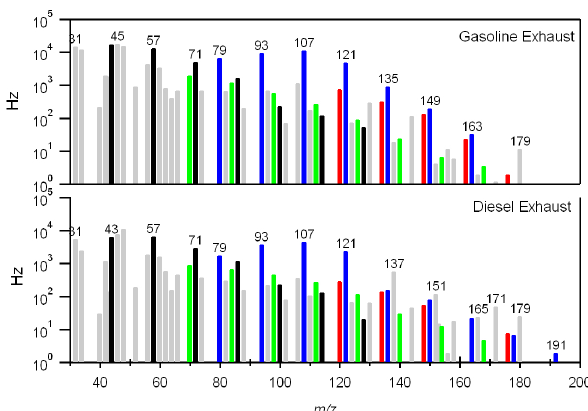
Fig. 6. PTR-MS mass spectrum of gasoline exhaust (top) and diesel exhaust (bottom) at 80Td. Ion signal has been color-coded to as- sign ions to common fragmentation patterns that identify common organic compound classes: alkene and alkane fragment ions (black), alkylbenzenes (blue), cycloalkane fragment ions (green) and naph- thenic monoaromatics (red). The abundance of unsaturated aldehy- des in diesel exhaust likely dominates ion signal at m/z 57 and